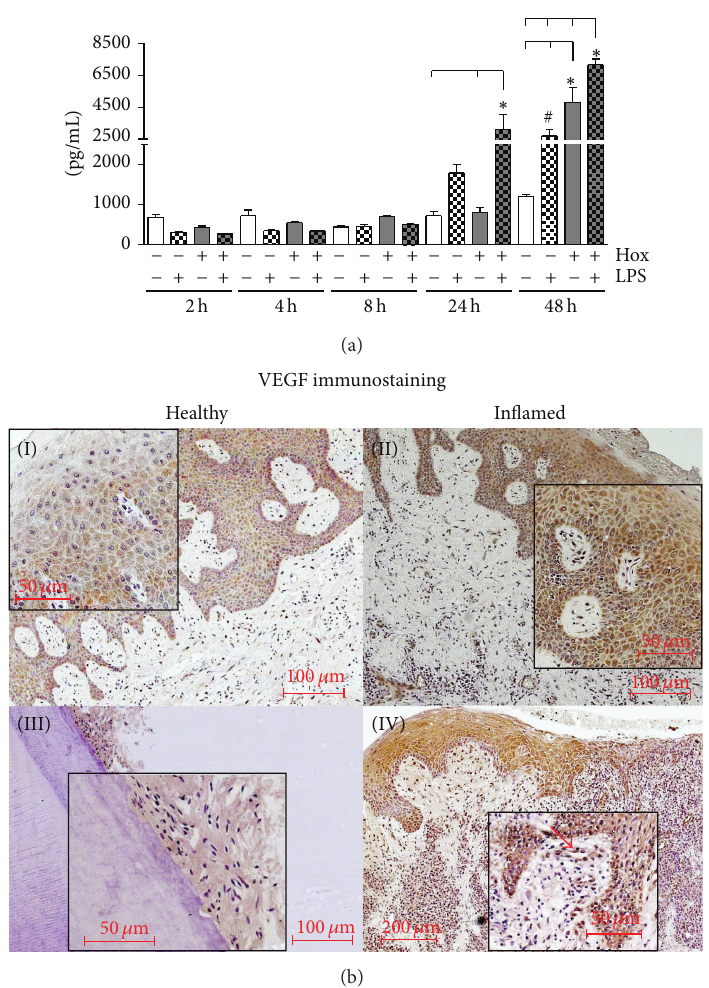
Figure 5: VEGF protein expression . (a) VEGF protein expression in PDL cells was measured using ELISA. Supernatants of PDL cells, stimulated with or without LPS-PG (1 𝜇 g/mL) under normoxic or hypoxic condition, were collected after varying time points (2, 4, 8, 24, and 48 h). Statistical differences were analyzed by one-way ANOVA and the post hoc Dunnett’s and Tukey’s multiple comparison test; # 𝑃 < 0.05 depicts a significant difference with respect to the time-matched control, ∗ 𝑃 < 0.05 indicates a significant difference between groups (means ± SD; 𝑛 = 9 ). (b) Healthy gingiva (I), gingivitis (II), healthy periodontal ligament (III), and periodontitis (IV) were obtained after the approval of the Ethics Committee of the University of Bonn and parental as well as patients’ written consent ( 𝑛 = 3 ). A polyclonal primary antibody against VEGF was used in a concentration of 1:100 for immunohistochemistry. The scale bars indicate 50, 100, or 200 𝜇 m in dependence of the